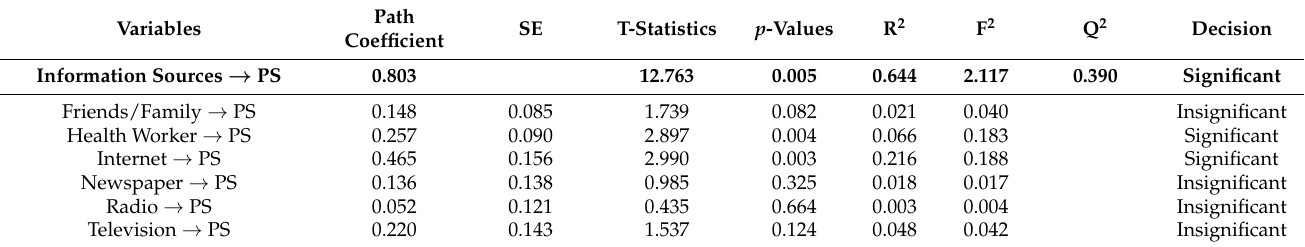
Table 5. Coefficient value of Hypothesis